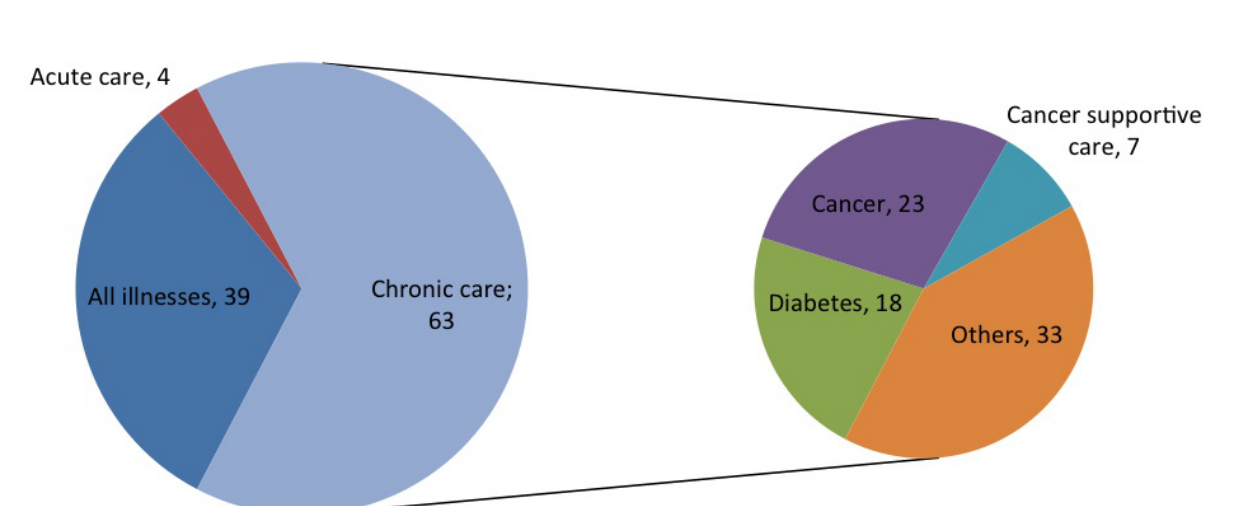
Figure 9. Analyzed